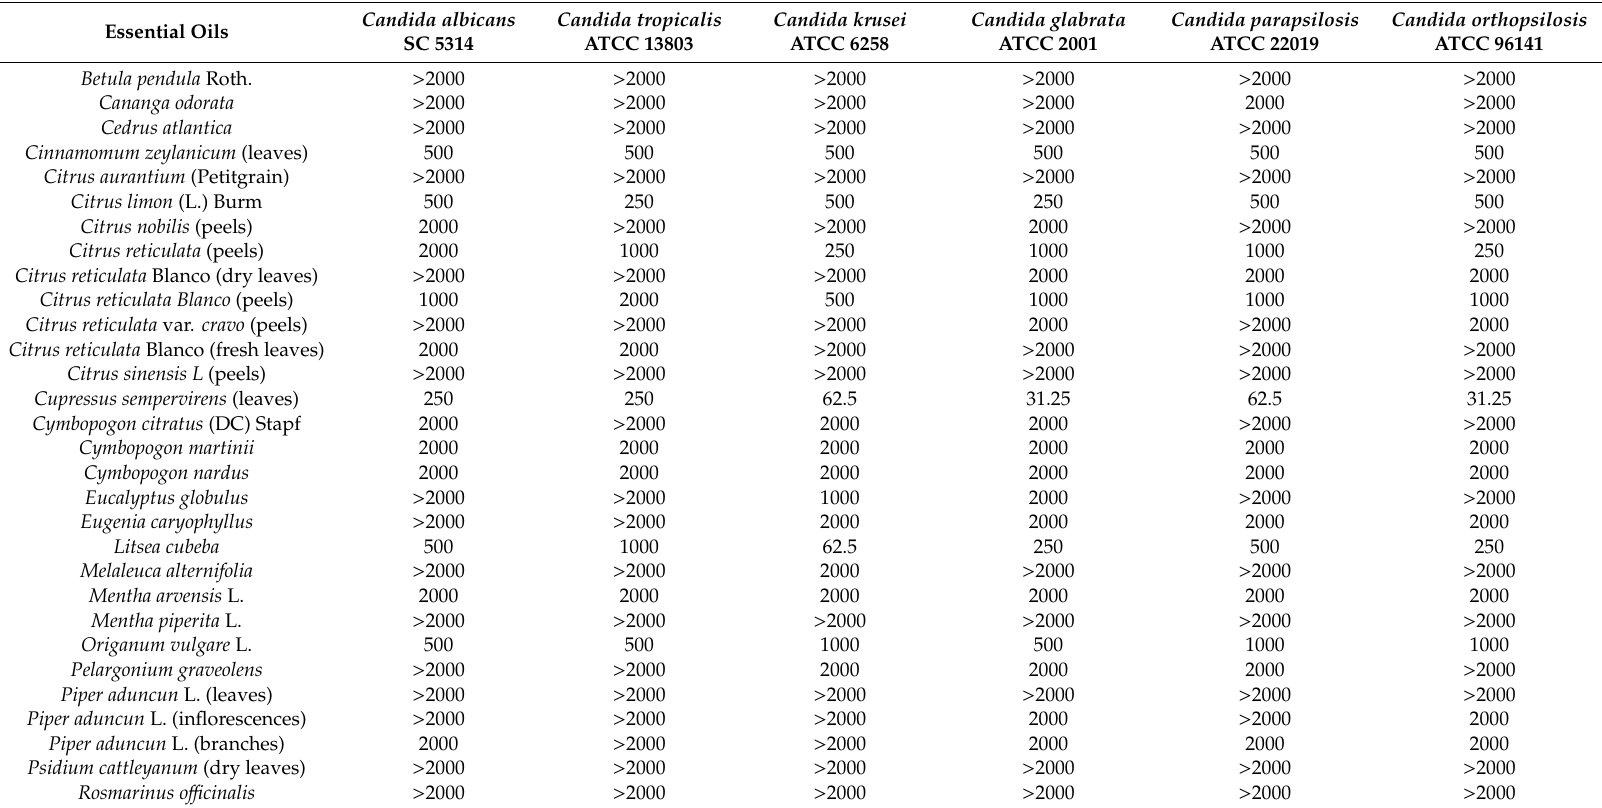
Table 1. Minimal Inhibitory Concentration ( µ g / mL) values of essential oils obtained against Candida species. Candida albicans Candida tropicalis Candida krusei Candida glabrata Candida parapsilosis Candida orthopsilosis Essential Oils SC 5314 ATCC 13803 ATCC 6258 ATCC 2001 ATCC 22019 ATCC 96141 Betula pendula Roth. Cananga